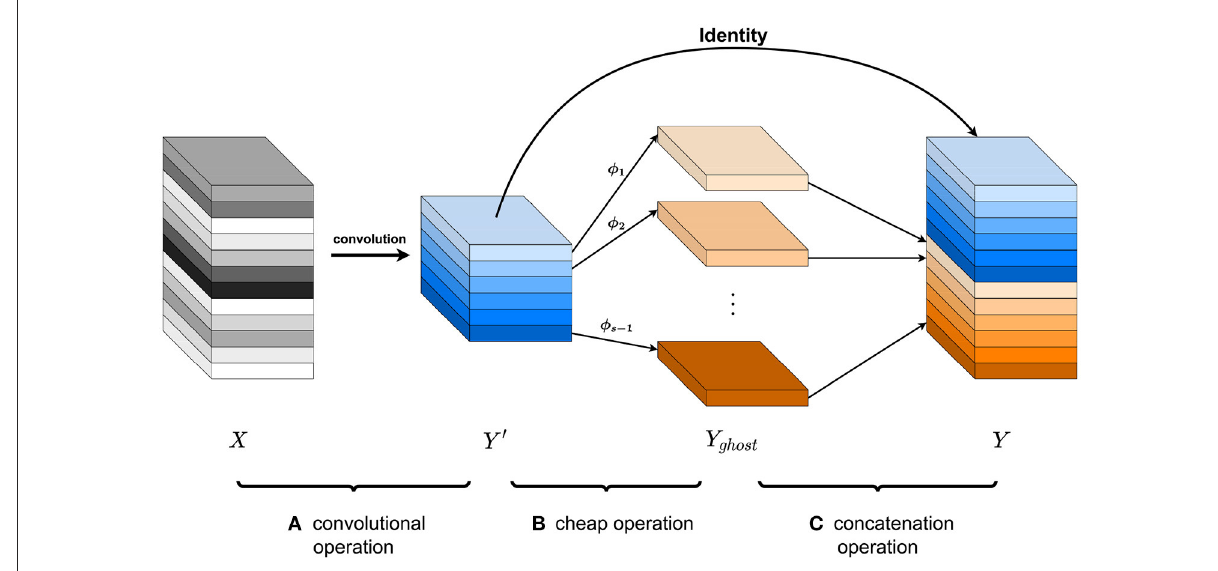
FIGURE2 Three parts of Ghost module operation. (A) A convolutional operation generates intrinsic feature maps of m channels from the input maps of n channels. (B) The cheap operation generates the ghost feature maps of s feature maps can be